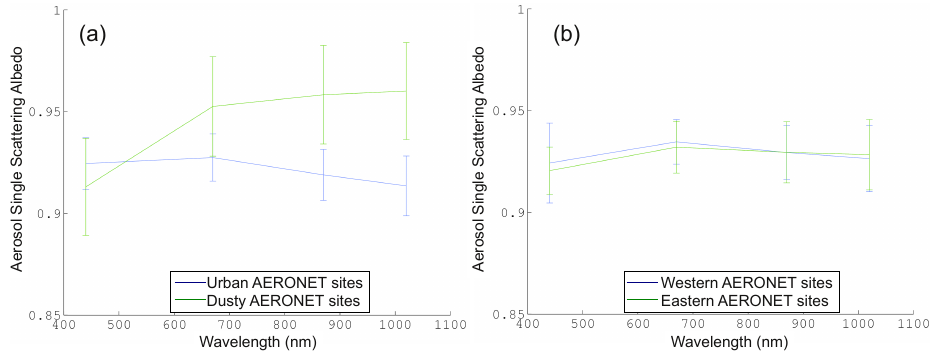
Fig. 11. Wavelength dependence of Single Scattering Albedo (SSA) for Urban and Dusty AERONET sites (a) and for Western and Eastern AERONET sites (b) . Standard deviations are also